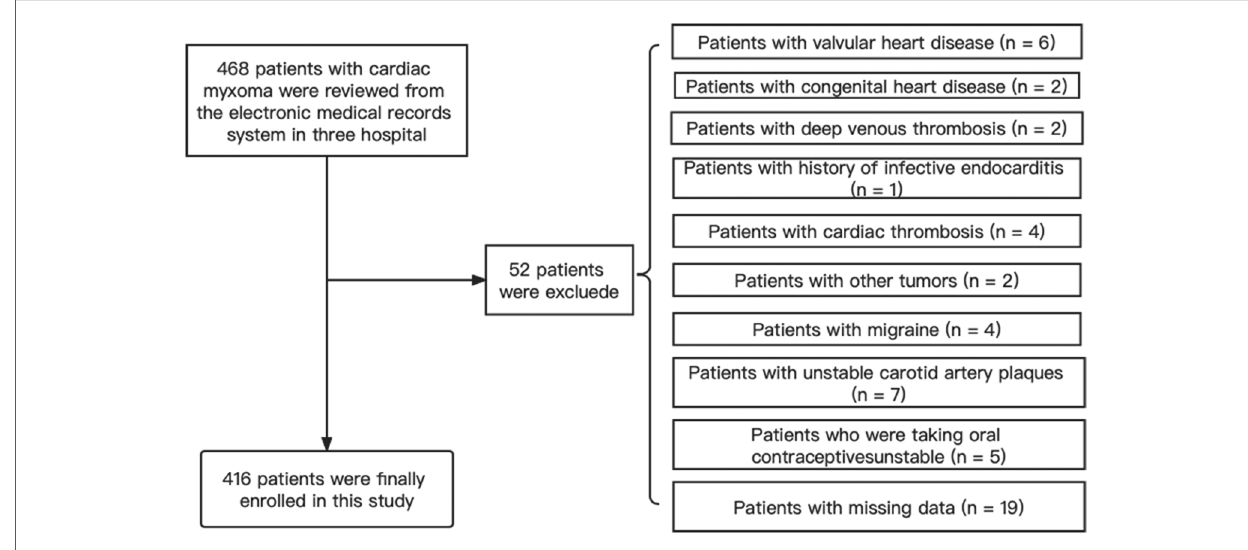
FIGURE 1 Flowchart describing the screening of patients with cardiac myxoma (CM).